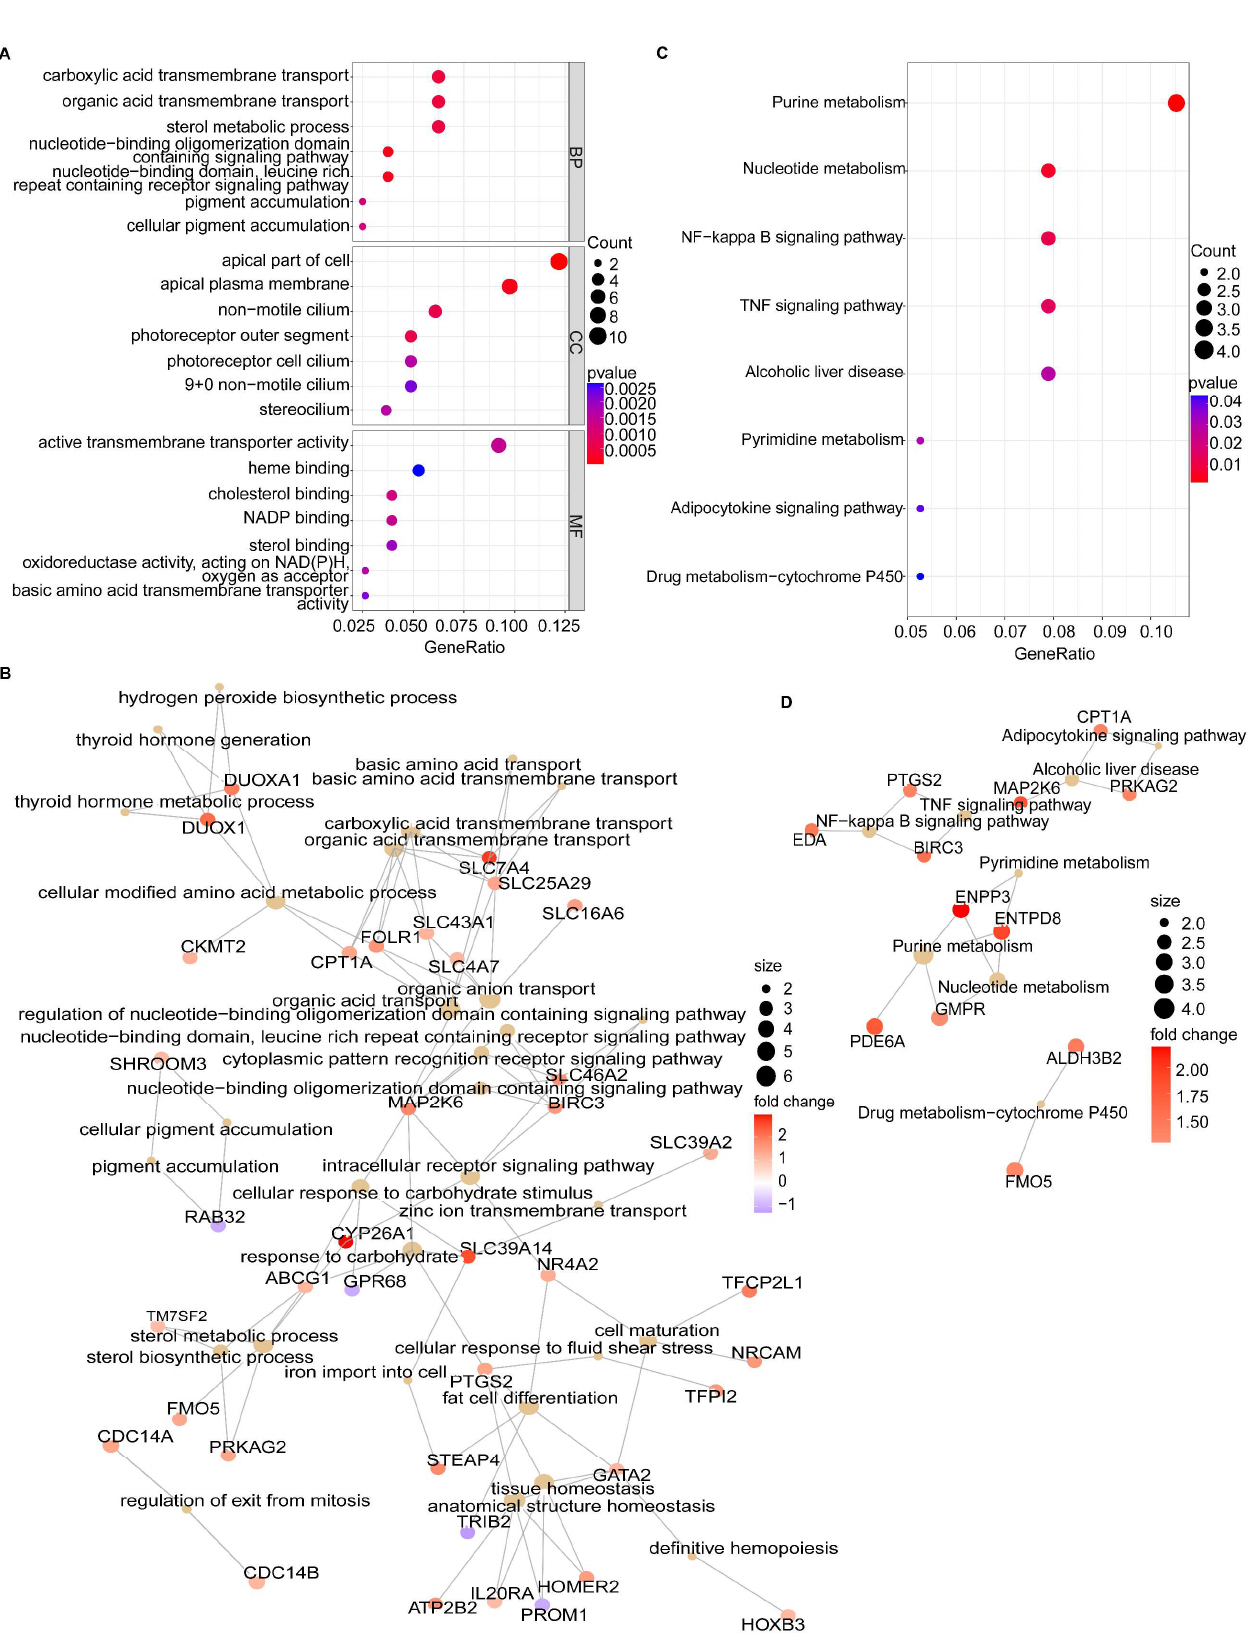
Figure 3. Functional enrichment analysis. ( A ) GO analysis of the 85 DEGs. ( B ) GO-cnet plot (the top 30 biological processes). ( C ) KEGG analysis of the 85 DEGs. ( D ) KEGG-cnet plot. GO, Gene Ontology; DEGs, differentially expressed genes; KEGG, Kyoto Encyclopedia of Genes and Genomes.